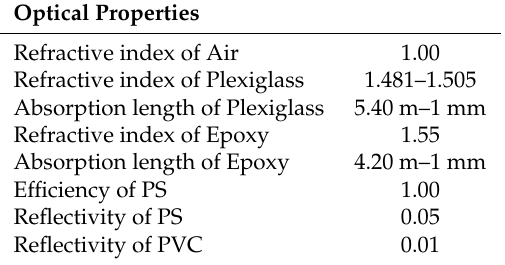
Table 1. Materials and surfaces optical properties implemented in the simulations. When two values are specified, the corresponding optical property varies with photon energies that spans from 2.00 to